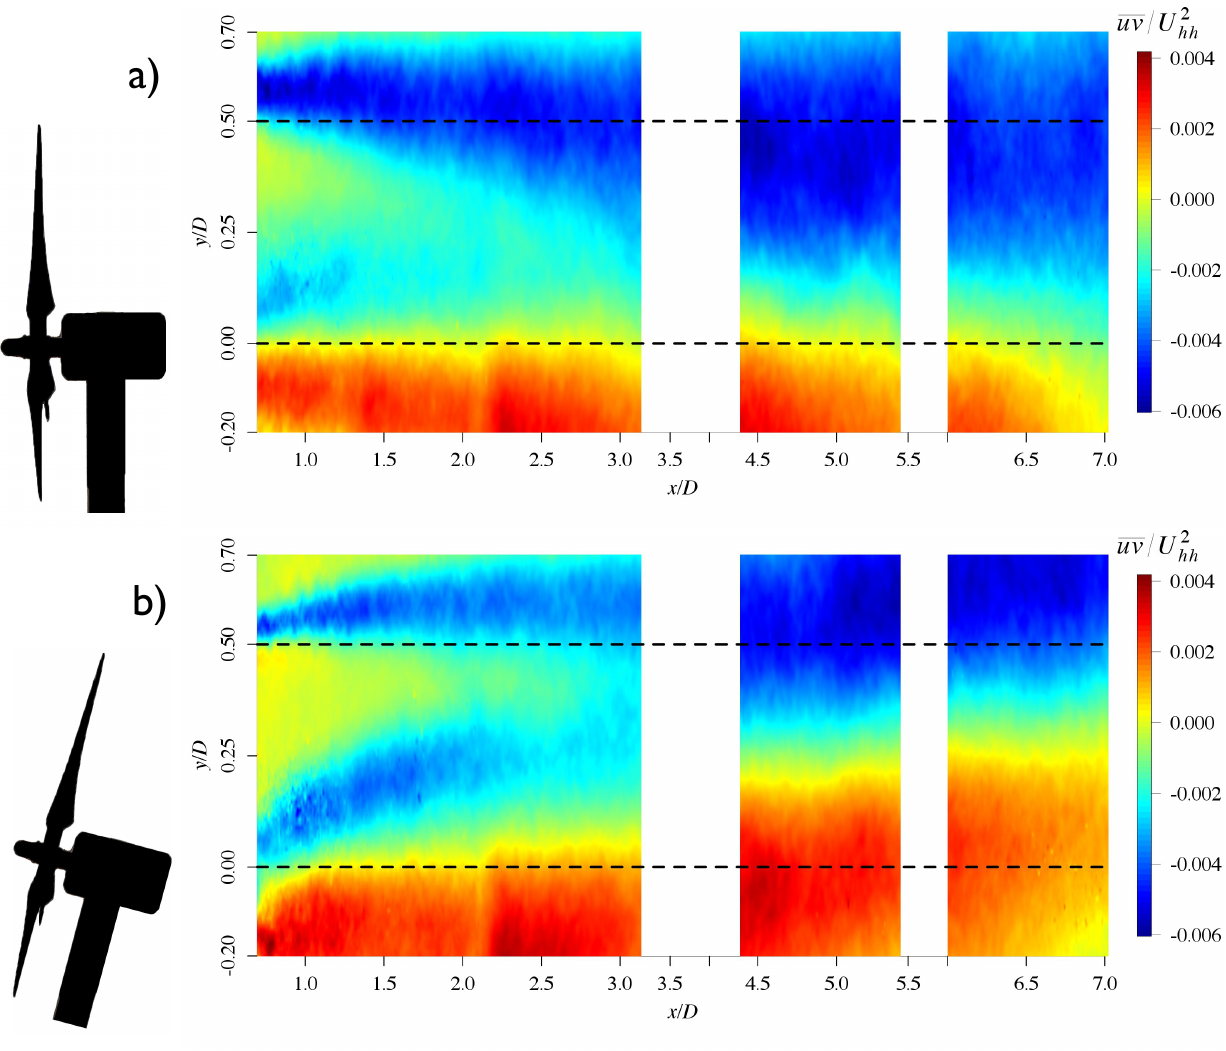
Figure 13. Contours of Reynolds shear stress uv / U 2 height ( y/D = 0) and top blade tip ( y/D = 0.5) are indicated by dashed horizontal